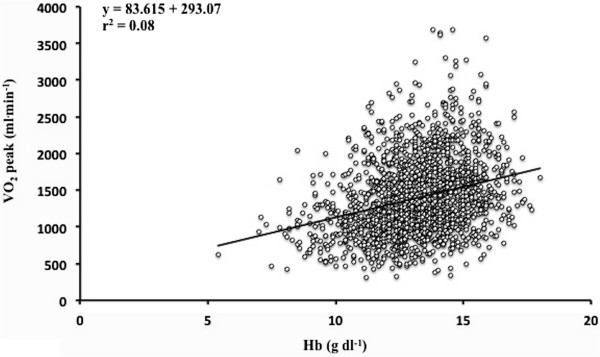
Linear regression between unadjustedV˙O2peak (ml min
-1
) and haemoglobin concentration ([Hb]), n = 1,774.